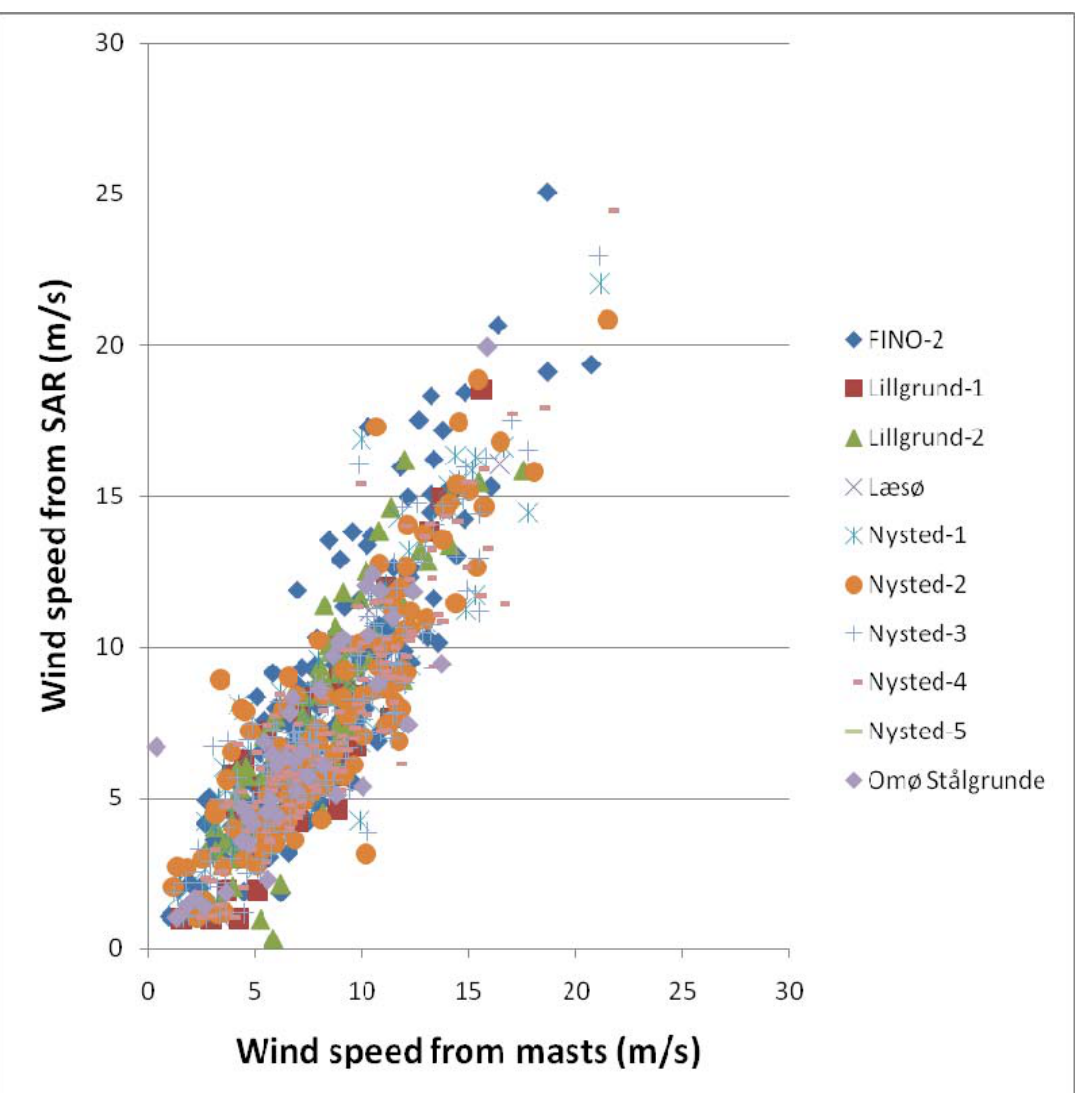
Figure 5. Wind speeds from ten meteorological stations versus SAR-based winds, excluding the wake sectors for Lillgrund-2 and Nysted-1/-2/-5, N =